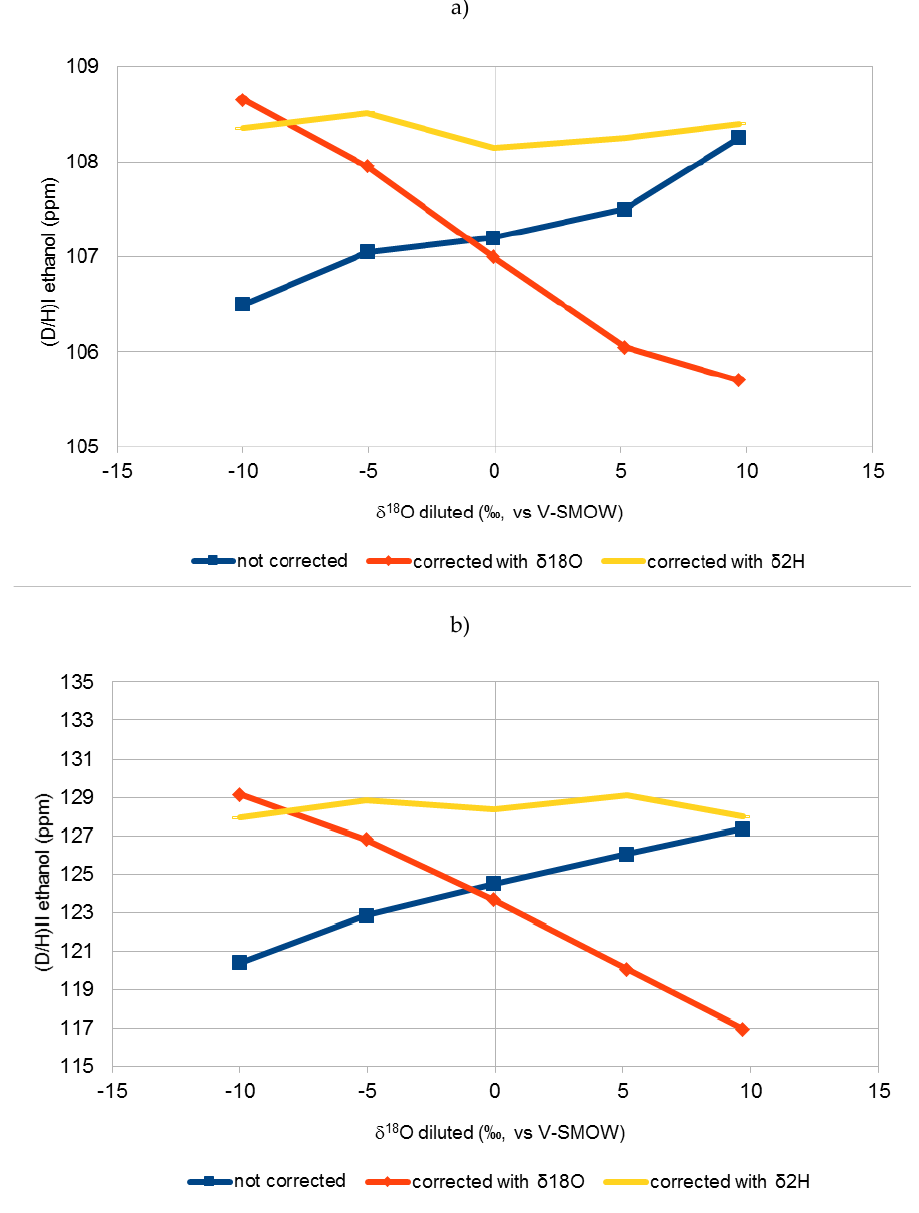
Figure 1 . Variation of uncorrected (D/H) I ( a ) and (D/H) II ( b ) values of ethanol vs. δ 18 O of water of diluted cane sugar samples (red line) and effect of the correction on the (D/H) I ( a ) and (D/H) II ( b ) of ethanol (Equations (1) and (2)) using δ 18 O (Equation (5)) (blue line) and δ 2 H (Equation (6)) (yellow line), values reported in Table 1 of the diluted sugar samples. Each point is the mean of two samples.